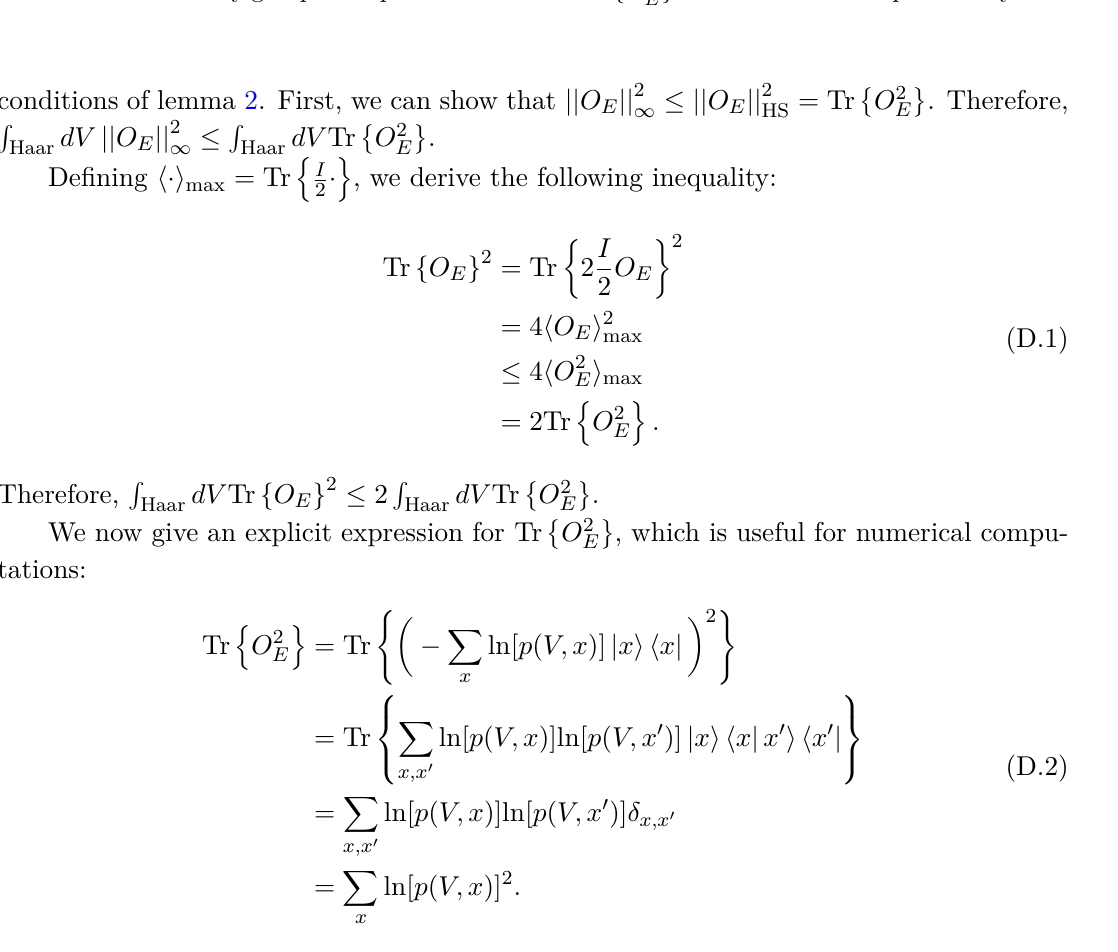
(cid:8) (cid:9) } = R dV Tr O 2 against the qubit number, n . The quantity Tr { O 2 E E Haar (cid:8) (cid:9) O 2 over 2000 unitaries randomly sampled from the Haar E } does not increase exponentially in n . E